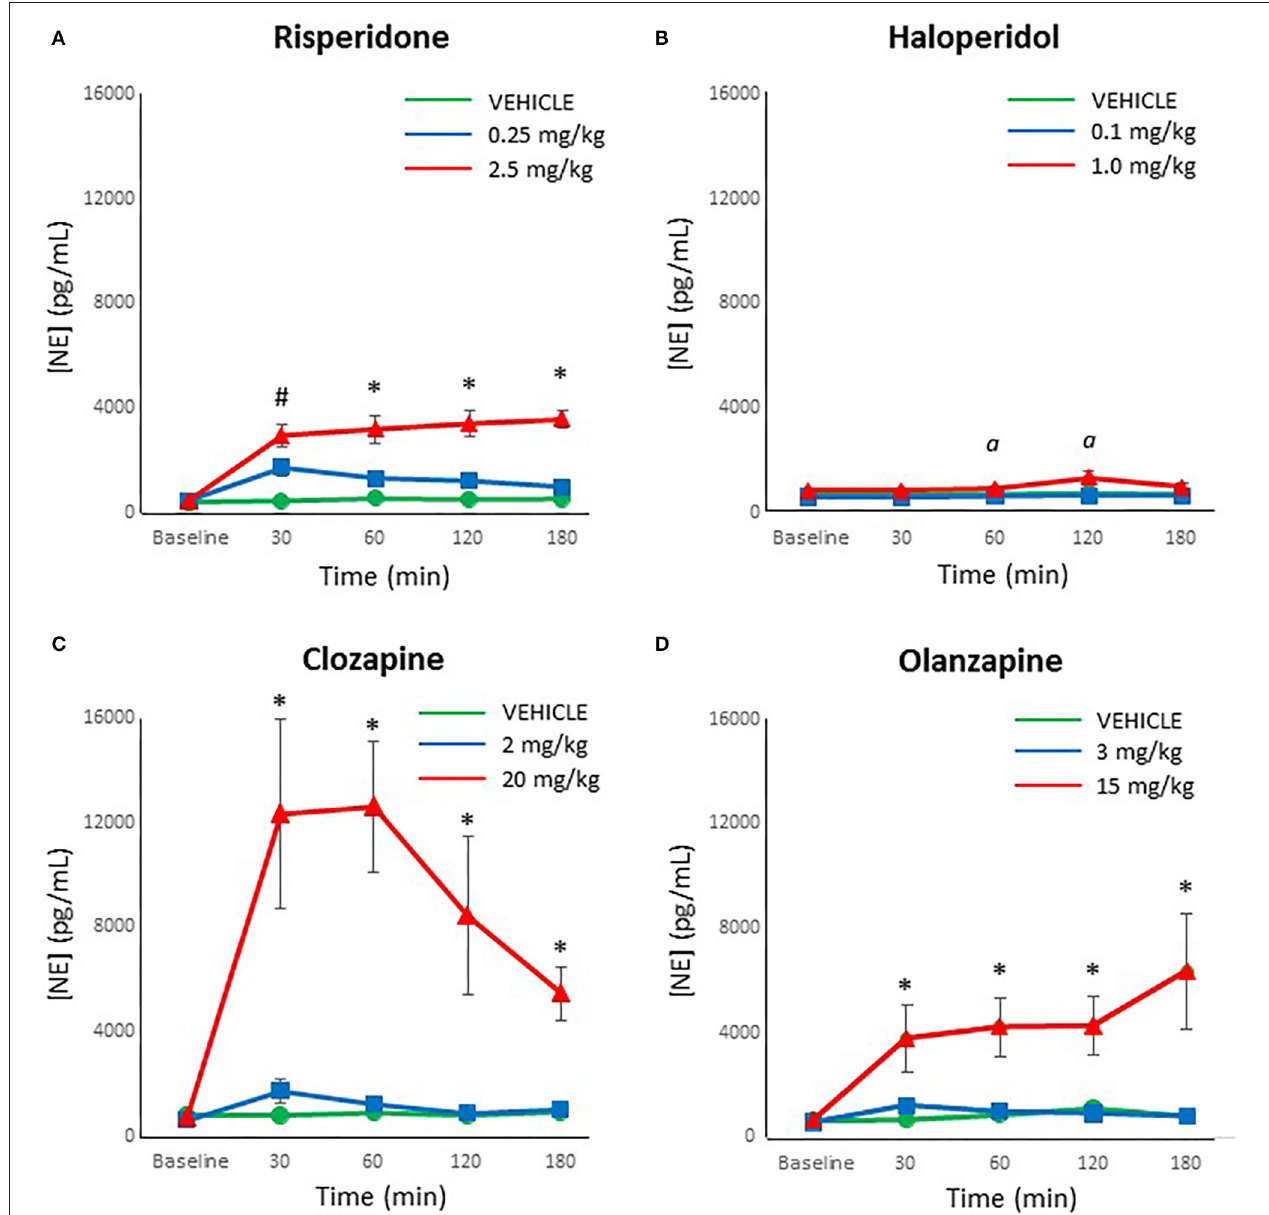
FIGURE 2 | Acute changes in plasma norepinephrine (NE) concentrations (pg/ml) after antipsychotic drug treatment in adult female rats. Animals ( n = 10 per group) were given a single IP injection of (A) risperidone (0.25 or 2.5 mg/kg) or (B) haloperidol (0.1 or 1.0 mg/kg) or (C) clozapine (2 or 20 mg/kg) or (D) olanzapine (3 or 15 mg/kg) or vehicle. Values are expressed in group means ± SEM. Plasma samples were collected immediately prior to drug treatment (Baseline) and at 30, 60, 120, and 180mins after treatment. # Statistically significant difference between both drug treated groups and vehicle, p < 0.05; * Statistically significant difference between high dose group and both other groups, p < 0.05; α Statistically significant difference between high dose group and vehicle, p < 0.05.